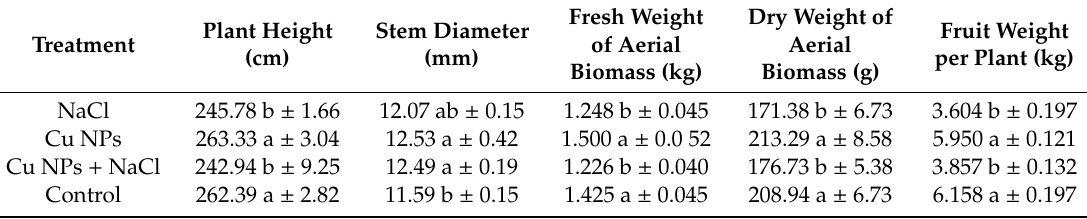
Table 1. Agronomic variables of tomato plants under salinity stress with and without the foliar application of Cu nanoparticles